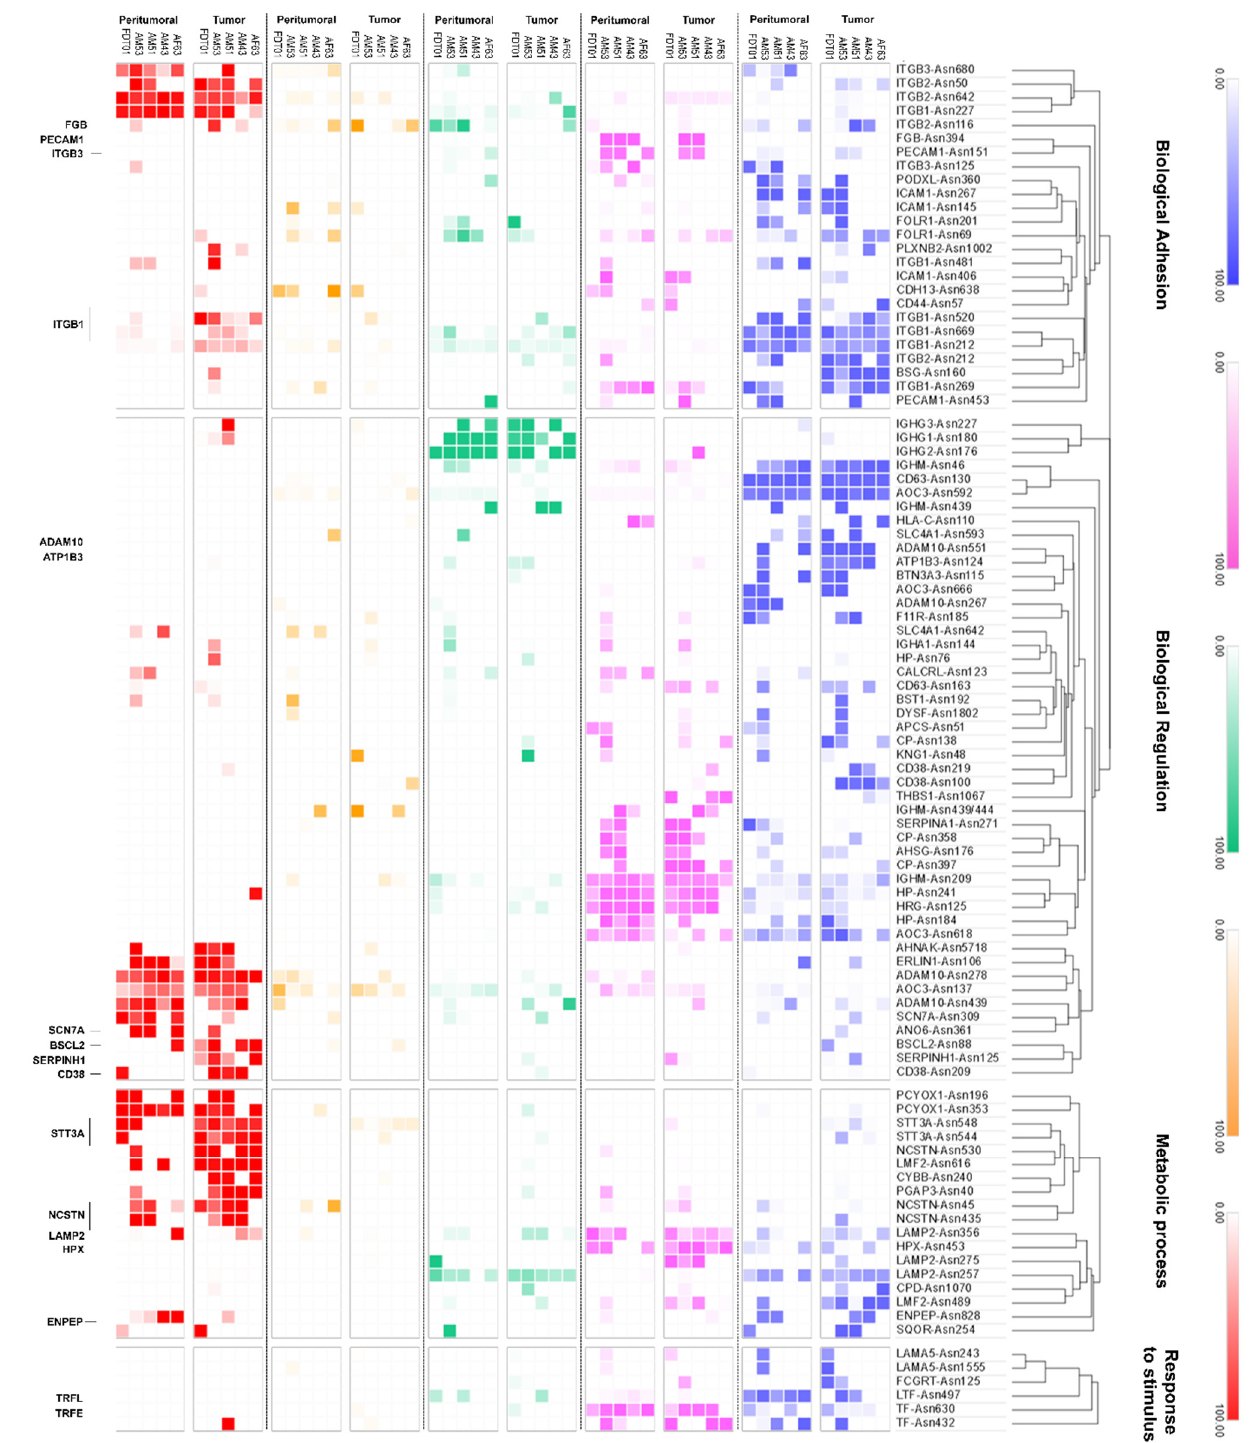
Figure 4. Glycan distribution maps of N-glycospeptides derived from cell surface proteins from tumor and peritumoral tissues, categorized according to the type—high-mannose (red), undecorated (orange), fucosylated (green), sialylated (pink), and sialofucosylated (blue)—and annotated according to biological processes—biological adhesion, regulation, metabolic process, and response to stimulus— as characterized using site-specific